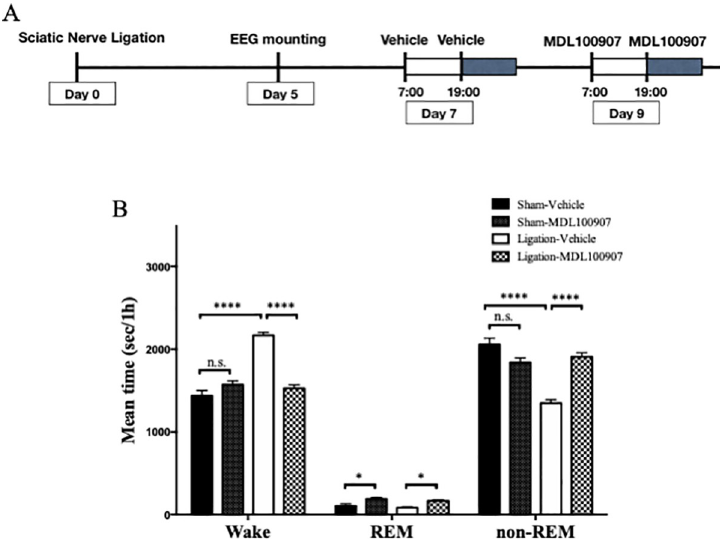
Fig 6. Selective 5HT 2A receptor antagonist improved quantity of sleep in neuropathic pain model. EEG and EMG were recorded for 24 hours with administration of vehicle (test day 7) and MDL 100907 (test day 9) (A). The mean value per hour of wake, REM sleep, and non-REM sleep time are represented for sham (n = 7) and nerve ligation groups (n = 7). Data are expressed as means ± SEM. Data are analyzed using two-way ANOVA followed by Bonferroni’s post hoc test and considered statistically significant at ��� P < 0.001, and ���� P < 0.0001 when comparing all groups (B).